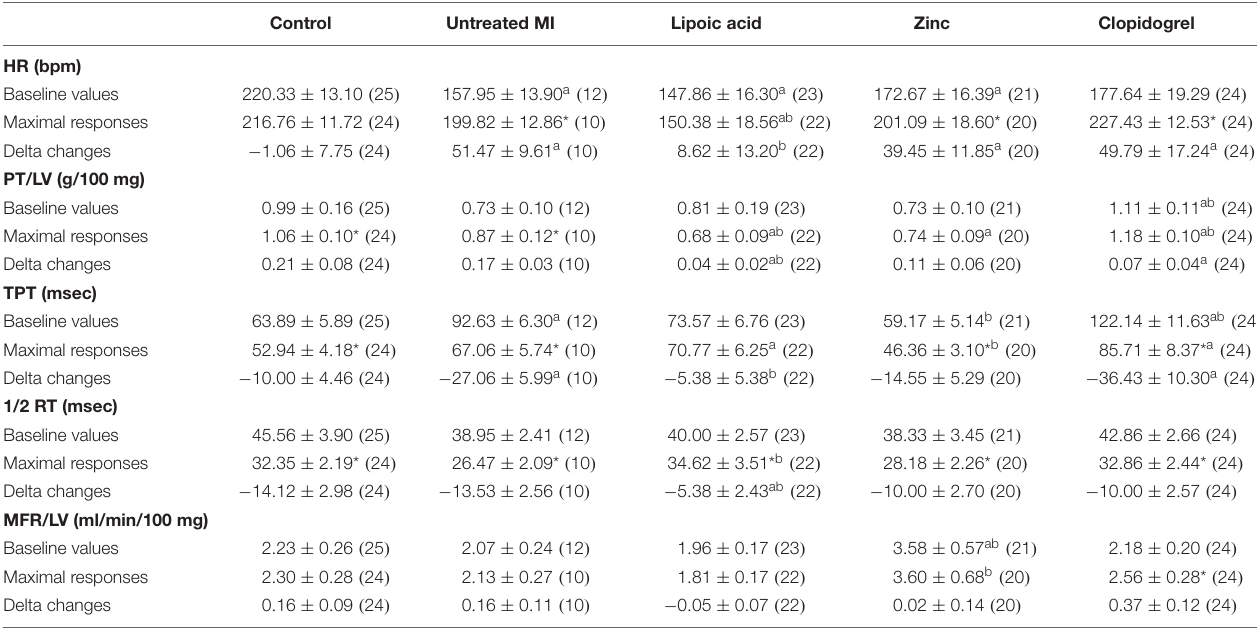
TABLE 5 | Intrinsic cardiac activities of perfused isolated hearts from the control, untreated MI, and pre-treated MI groups.